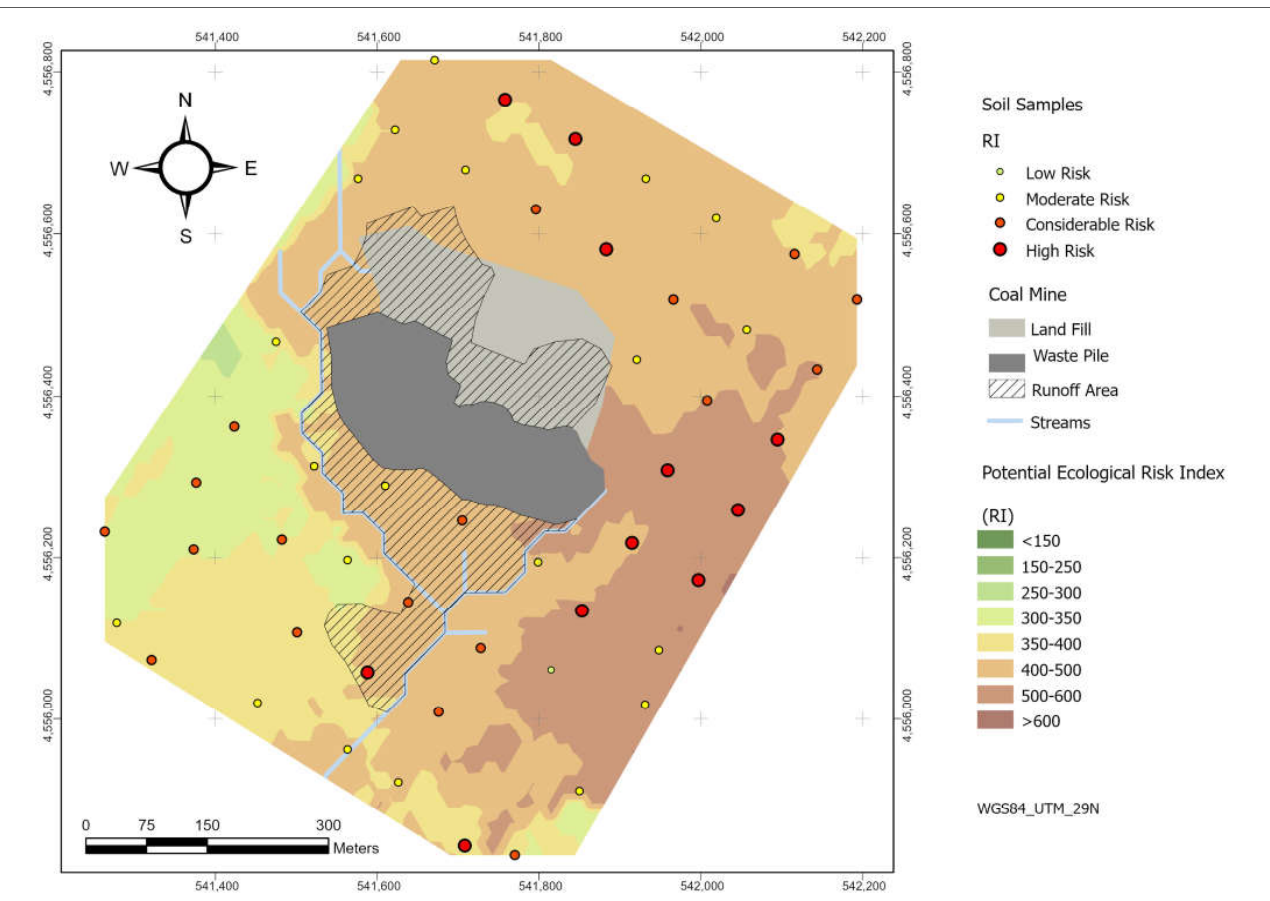
Figure 5. Potential ecological risk index determined using crustal average as the geochemical base- line.